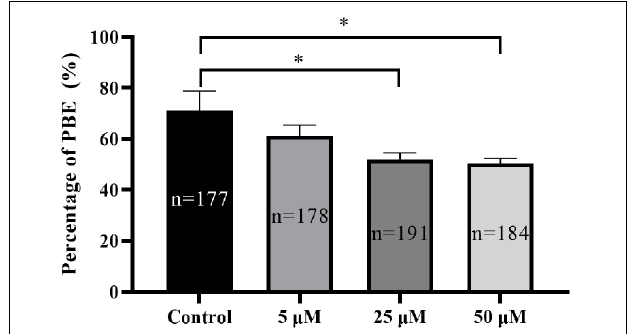
FIGURE 1 | Effects of TBTO exposure on porcine oocyte maturation. Percentage of oocytes with PBE in each group. The numbers of oocytes examined from the different groups are indicated by the bars. ∗ p < 0.05 compared to the control.